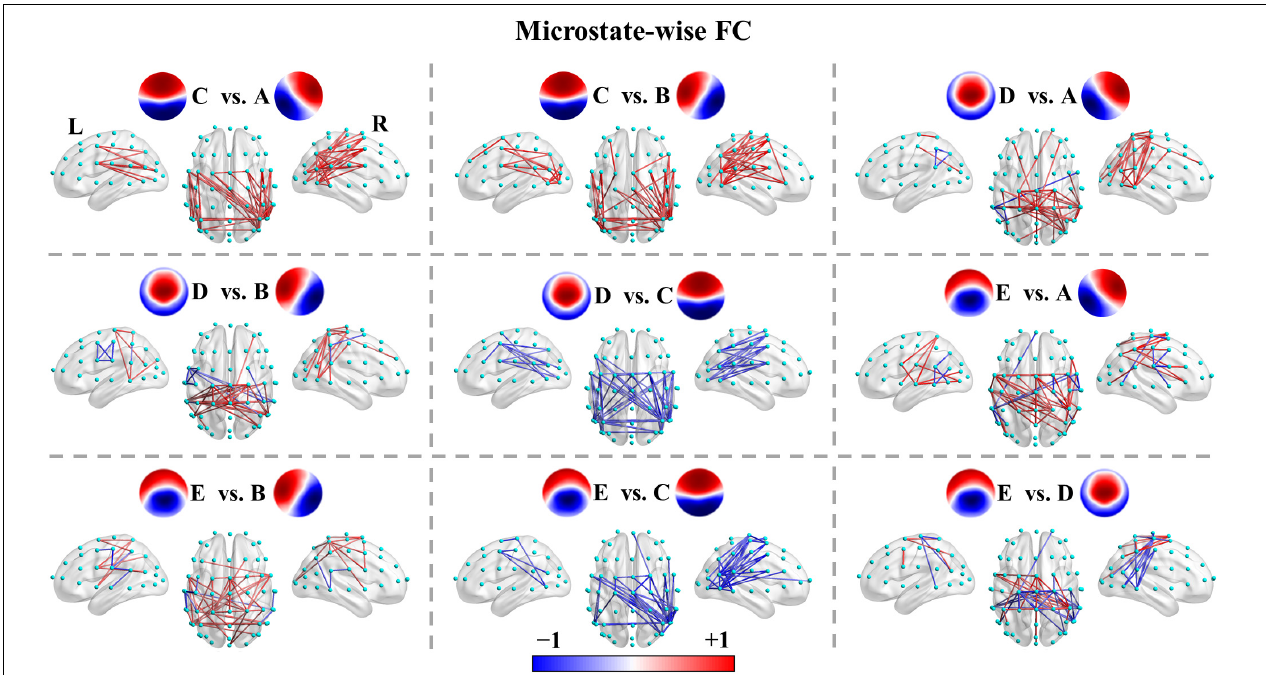
FIGURE 4 | Microstate-wise functional connectivity comparisons in healthy controls. For X vs. Y, the red color indicates greater connectivity for microstate X vs. microstate Y, while the blue color indicates greater connectivity for microstate Y vs. microstate X. Color depth represents the size of the connection difference ( t -value). For visual clarity, only the top 50 connections (according to absolute t -values) of the connected components with significant differences ( p < 0.05, NBS-based method corrected) are displayed in the figure. The complete significant connected components of the four groups are shown in the first column of Supplementary Figures 4–12